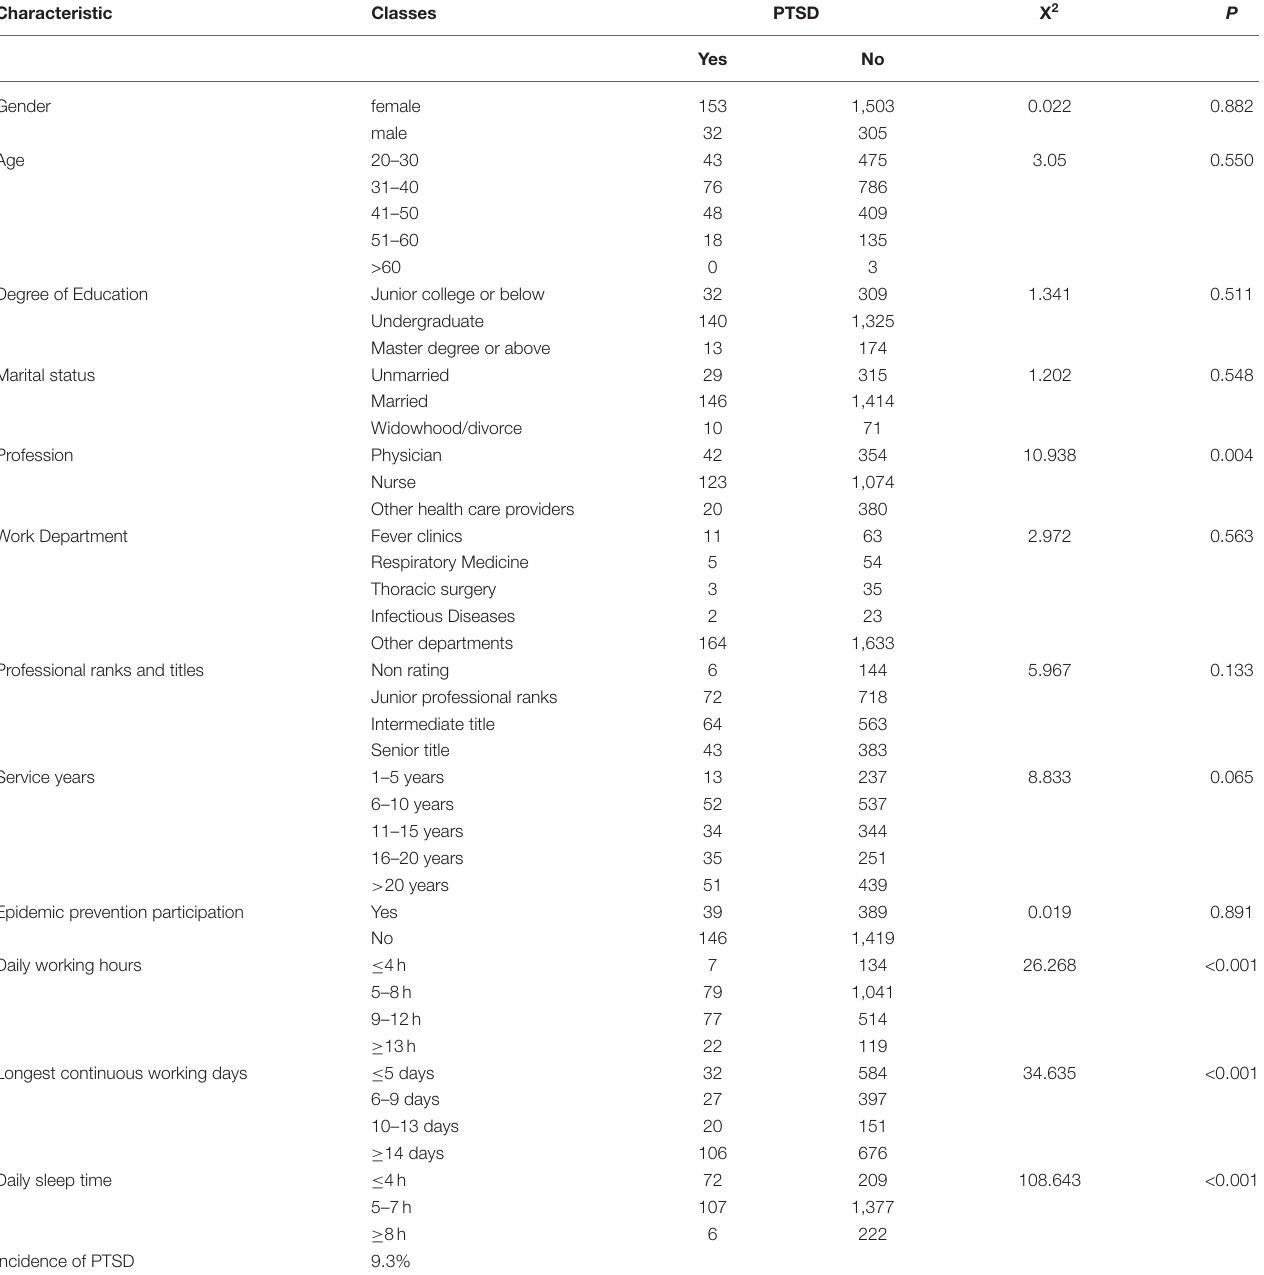
TABLE 2 | Chi-square test for PTSD-related risk factors ( n = 1,993).